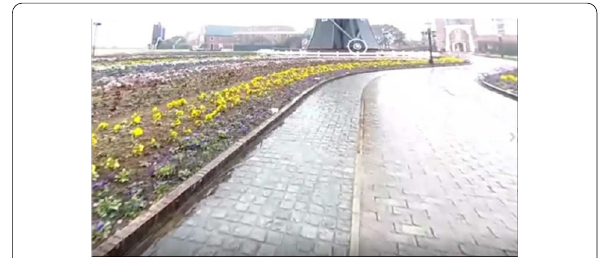
Fig. 30 View presented by the co-experience